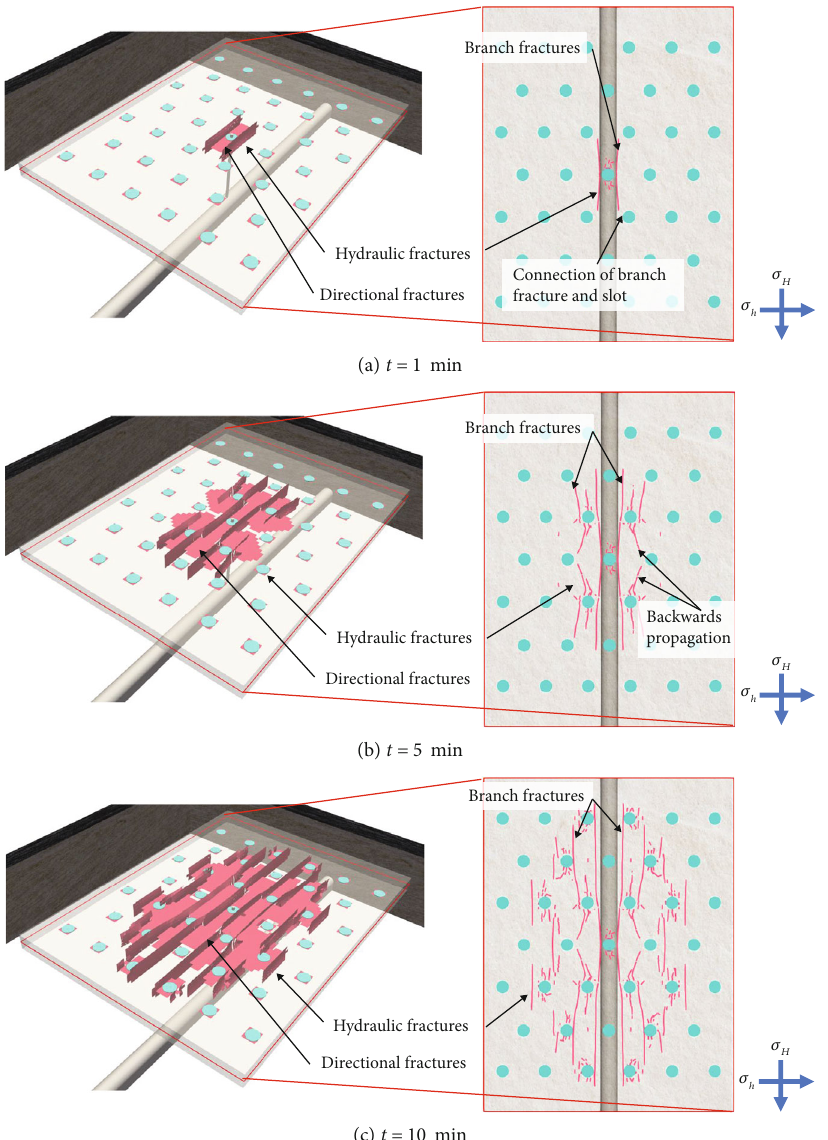
Figure 15: Temporal development of the hydraulic fracture pattern created by hydraulic fracturing in combination with a staggered distribution of hydraulic